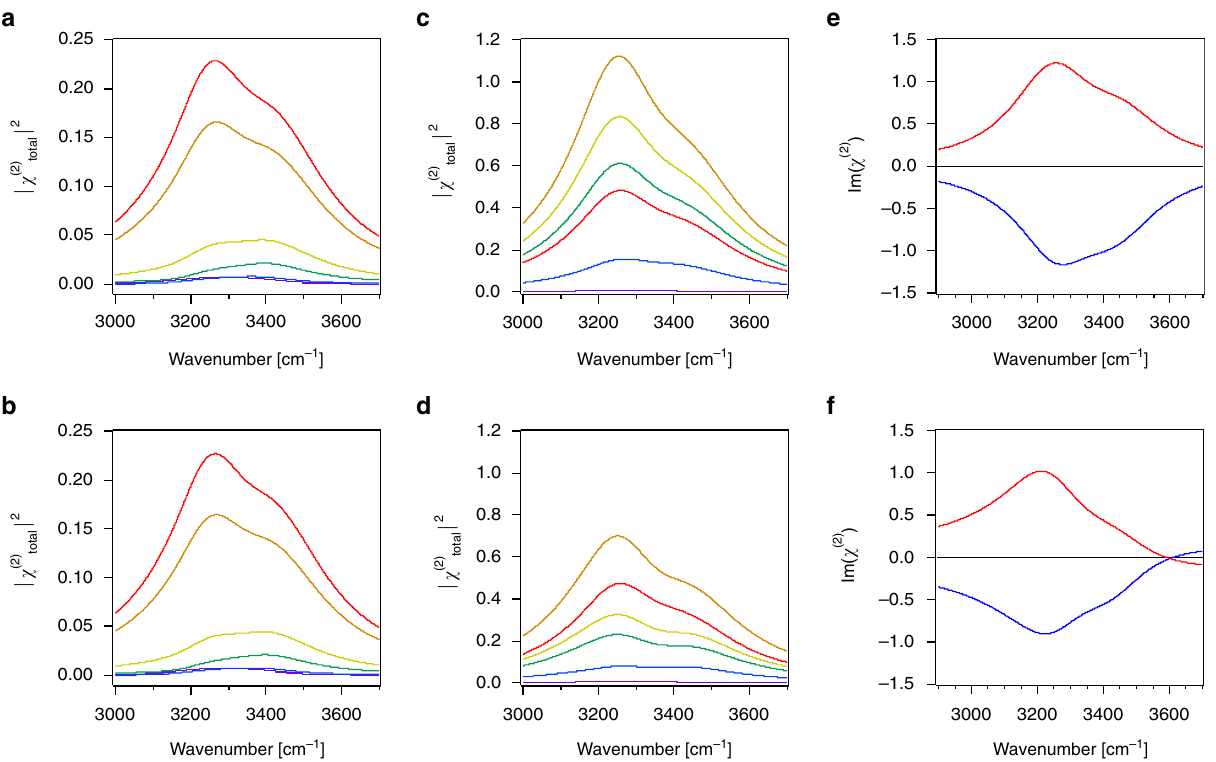
Fig. 4 Charged solid/water interface. SFG intensity spectra for two oscillators on a charged surface simulated for ω 1 = 3200 cm − 1 , γ 1 = 0°, ω 2 = 3400 cm − 1 , γ = 180°, A M = A M = 10, Γ = Γ = 120 cm − 1 , χ (3) = 500, and χ (3) = 150 using charge densities of + 0.001 (purple), − 0.005 (blue), − 0.025 (green), 2 1 1 2 2 1 2 1 2 − 0.05 (yellow), − 0.17 (orange), and − 0.25 (red) C/m 2 and a constant ionic strength of 0.1 M calculated without a and with b absorptive-dispersive interactions. c , d Same as in a , b but for ionic strengths that vary with charge density as in A and B as follows: 10 mM at + 0.001 C/m 2 (purple), 100 μ M at − 0.005 C/m 2 (blue), 40 μ M at − 0.025 C/m 2 (green), 40 μ M at − 0.05 C/m 2 (yellow), 100 μ M at − 0.17 C/m 2 (orange), and 10 mM − 0.25 C/m 2 (red). e , f Im( χ (2) ) spectra with ω 1 = 3200 cm − 1 , γ 1 = 180°, ω 2 = 3400cm − 1 , γ 2 = 0°, A 1 M 1 = A 2 M 2 = 10, Γ 1 = Γ 2 = 120 cm − 1 , χ (3) 1 = 500, and χ (3) 2 = 250 calculated using charge densities of + 0.2 (blue) and -0.2 (red) C/m 2 and a constant ionic strength of 100 μ M, without e and with f